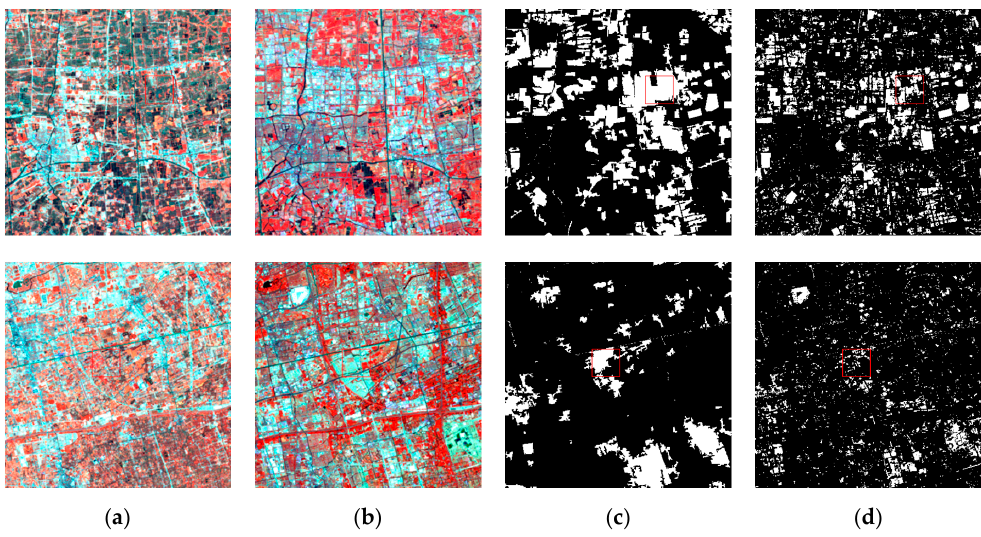
Figure 7. Change detection result comparison. Remotely sensed images for ( a ) 2000 and ( b ) 2011. ( c ) Change detection results for the proposed ECVA_OB method and ( d ) MCVA_PB method. Table 3. Error matrix and accuracy assessment for binary change detection with ECVA_OB and MCVA_PB methods.